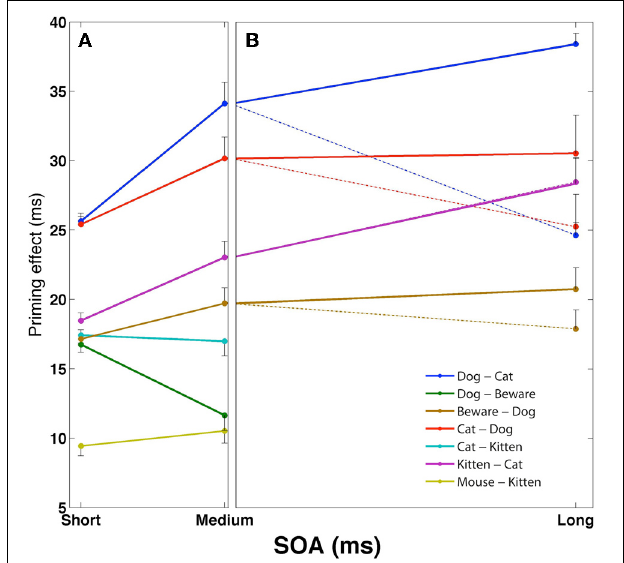
FIGURE 2 | Mean facilitation effects as a function of SOA for various prime-target pairs using the semantic structure in Figure 1C. Error bars represent ± 1 standard error of the mean. (A) SOA effects at short and medium SOAs, under default automatic conditions. (B) Long SOA priming effects for the associative pairs from (A) , separated to automatic conditions (dotted lines) and controlled-processes conditions in which reinforcement learning of the noise was applied (solid